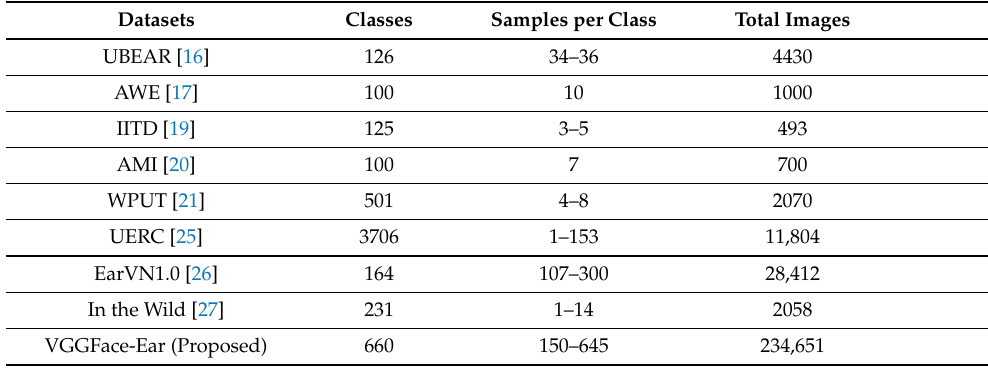
Table 1. Overview of available ear datasets in the